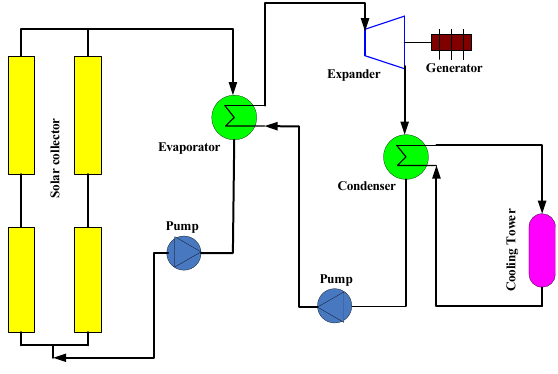
Figure 14. Solar-driven organic Rankine cycle power generation system diagram. Table 4. Solar energy utilization and development forecast in major regions of the world. (unit: o il equivalent 106).